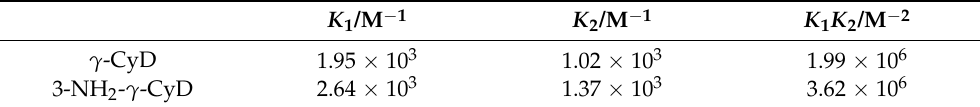
Figure 4. ( a ) Changes in UV-Vis spectra of 1-Zn in the presence of ATP with increasing concentrations of γ -CyD. ( b ) Plot of the absorbance ratio ( A 474 / A 434 ) of 1-Zn versus concentrations of ( • ) 3-NH 2 - γ -CyD and ( (cid:78) ) γ -CyD in the presence of ATP. [ 1-Zn ] = 0.02 mM; [HEPES] = 5 mM; [ATP] = 2 mM; [CyD] = 0, 0.020, 0.2, 0.4, 0.6, 0.8, 1.0, 1.2, 1.4, 1.6, 1.8, 2.0 mM, in 1% DMSO aq. at pH 7.4. Table 1. Equilibrium constants of 1-Zn /CyD complexes in the presence of